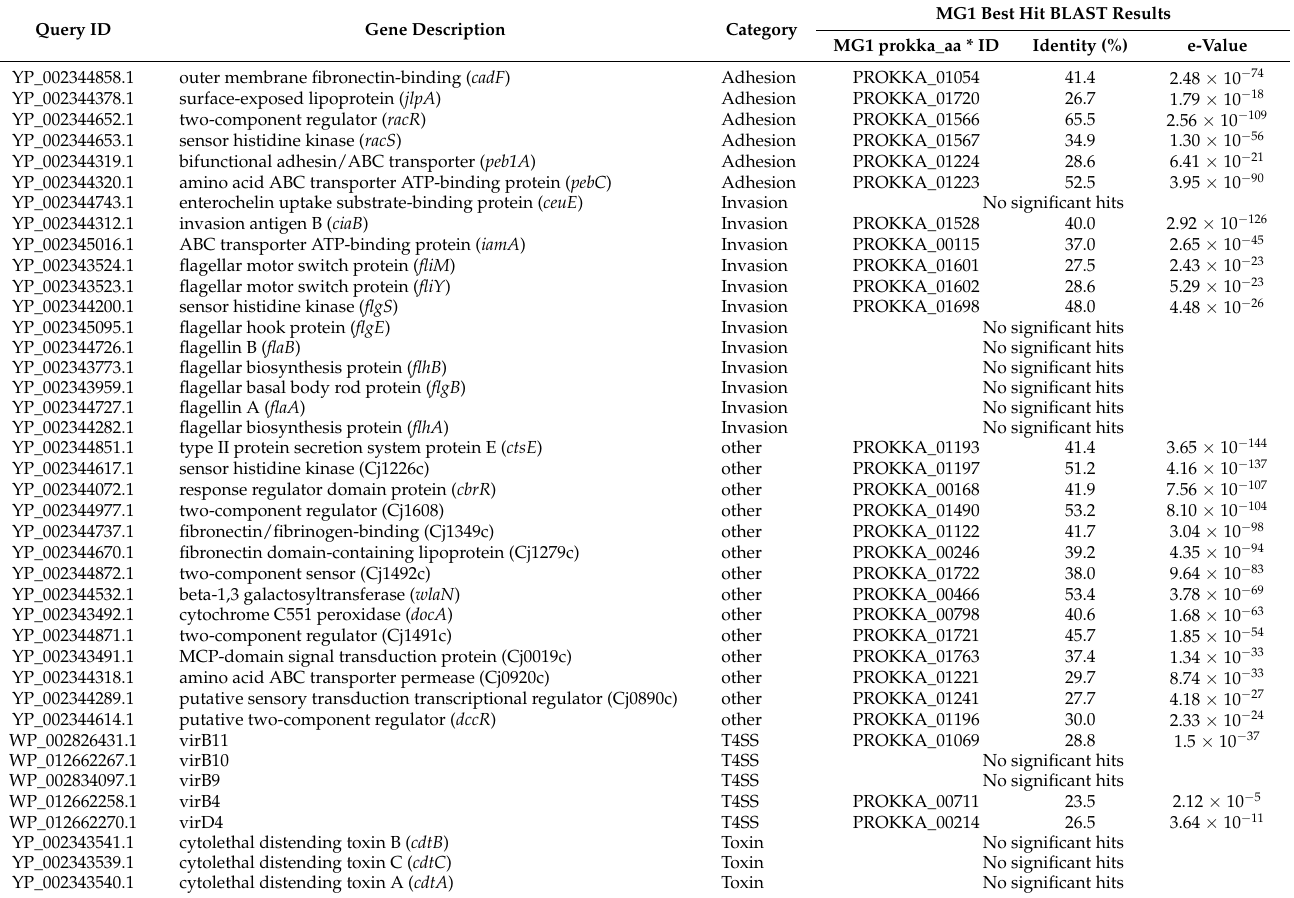
Table 2. Presumptive MG1 virulence genes identified by BLAST analysis of protein sequences. Query sequences are predominantly from C. jejuni (see Materials and Methods).